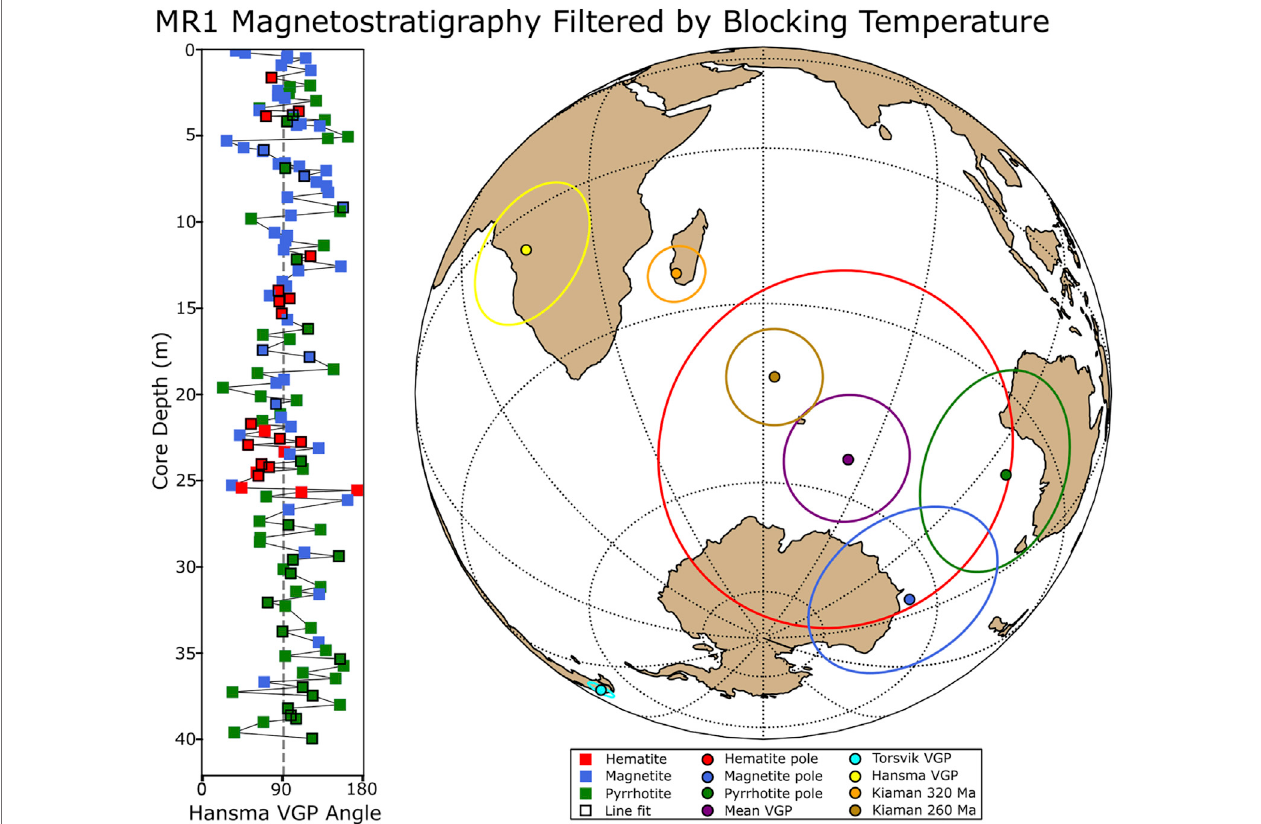
FIGURE 6 | MR1 directional data with mineralogy and MR1 pole positions. The MR1 VGPs plotted as an angle from the paleopole calculated by Hansma et al. (2015) forthe Canning Basin and then color coded bymineralogy interpreted from blocking temperatures. Hematite (red) above 600 ° C,magnetite (blue) between 350 ° C and600 ° C,pyrrhotite(green)below350 ° C.PolepositionswithA95showninsphericalprojection[red:hematitespecimensonly,blue:magnetitespecimensonly,green: pyrrhotite specimens only, purple: mean VGP, yellow: Torsvik et al. (2012) pole for Gondwana at 370 Ma, cyan: Hansma et al. (2015) pole for Canning Basin, orange: Gondwana Kiaman overprint from Torsvik et al. (2012) at 320 Ma, brown: Gondwana Kiaman overprint from Torsvik et al. (2012) at 260 Ma]. See Supplementary Figure S4 for Equal Area plots and Fisher means. The hematite pole plots near the Kiaman overprint and/or between the present local fi eld and the Kiamanoverprintandistreatedwiththehighestcon fi dence.Thepyrrhotiteandmagnetitepolesplotdonotplotnearthepresentlocal fi eldortheKiamanoverprintbutdo overlap with each